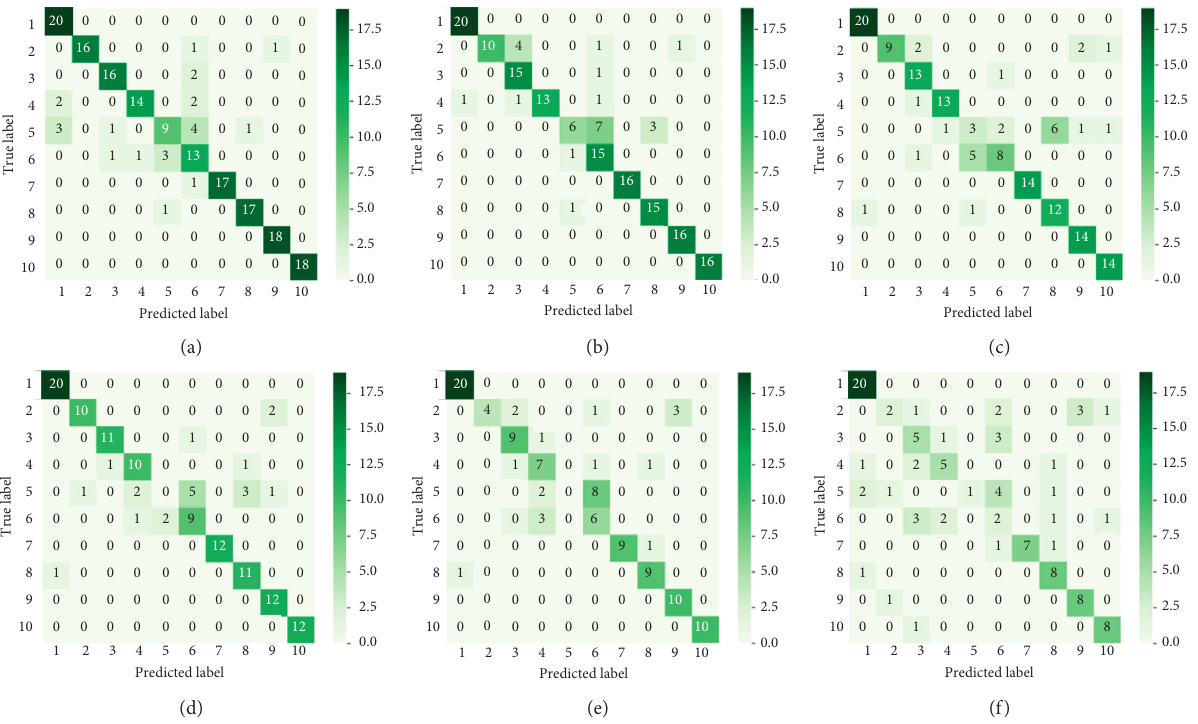
Figure 13: Confusion matrices of NCNN for the ten-classes scenario in different cases. (a) Case 2. (b) Case 3. (c) Case 4. (d) Case 5. (e) Case 6. (f) Case